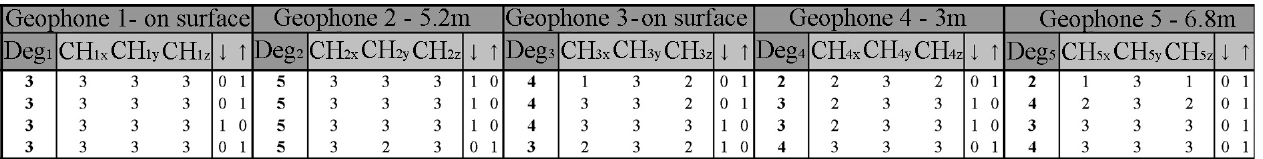
Fig. 6. Structure of the event analysis table: each line corresponds to one event. “Deg i ”: the amplitude of the signal observed on the geophone compared to the other geophones; “CH ij ”: the amplitude of the signal observed on each channel of one geophone; “ ↑↓ ”: the direction of the first peak value for the